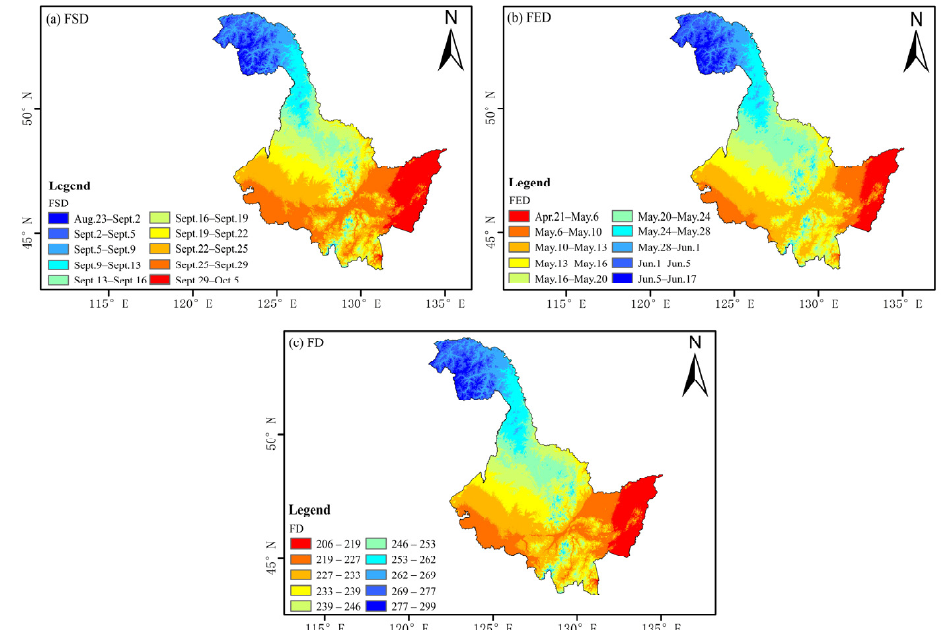
Figure 2. Spatial distribution of FSD ( a ), FED ( b ) and FD ( c ) of the soil freeze–thaw processes in Heilongjiang Province from 1971 to 2020.